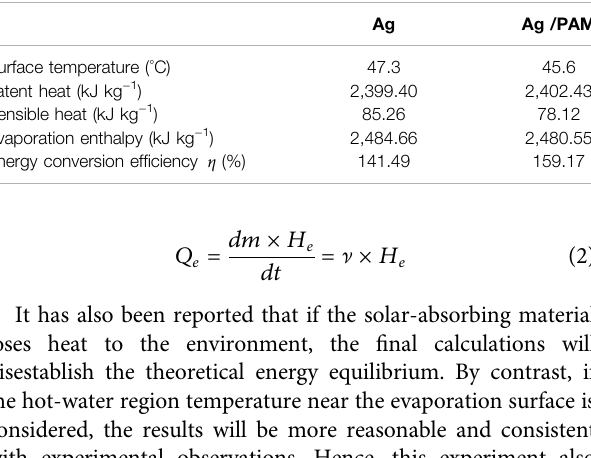
TABLE 3 | The surface temperature, latent heat, sensible heat, evaporation enthalpy,and energyconversion ef fi ciencyofAgand Ag/PAMmaterialsunder one Sun irradiation with